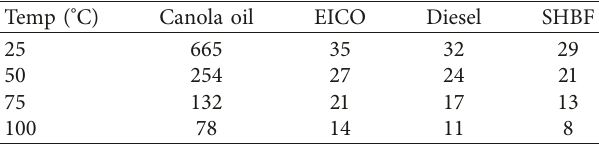
Table 3: Ostwald viscometer (size 200) effluent time (seconds) of base fluid samples.